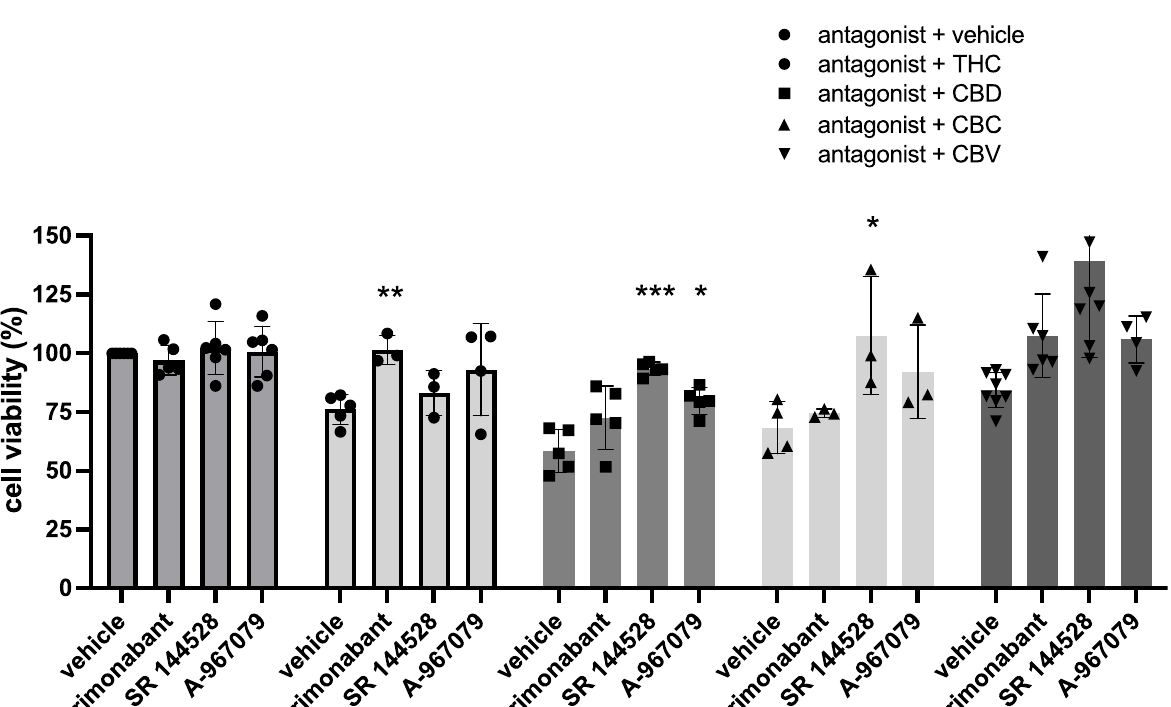
Fig. 2 Effects of antagonists on cell viability. Cell viability of T24 cells was assessed after 2-h treatment with various cannabinoids at 5 mM, to identify potential targets by which the cannabinoids mediate their effects on cell viability of bladder cancer cells. The first 4 bars show the effects of the antagonists alone, where their effects were minimal at the concentrations used. The subsequent sets of bars show their effects on blocking Δ. 9 -tetrahydrocannabinol, cannabidiol, cannabichromene, and cannabivarin, respectively. Results are means experiments. * p < 0.05, *** p <